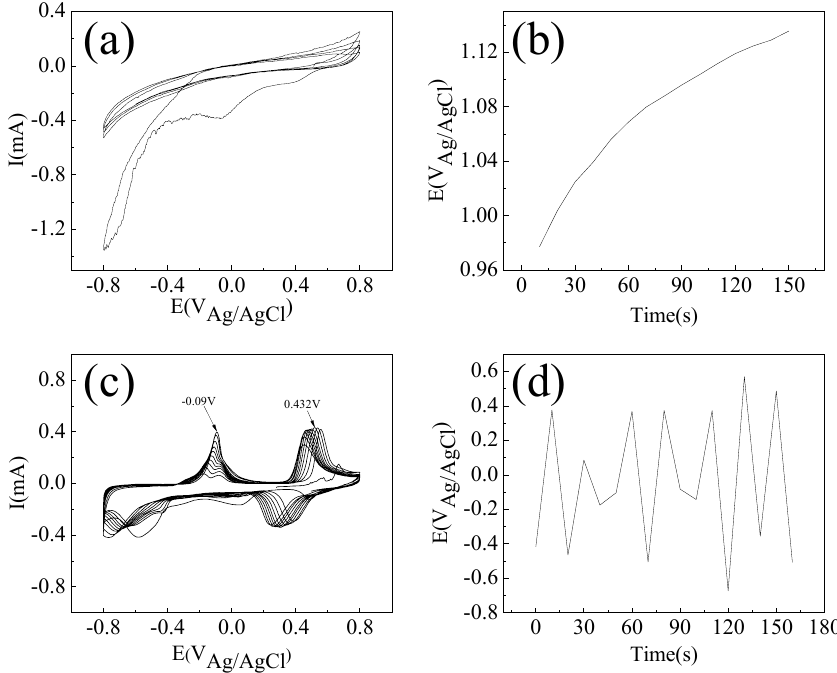
Figure 3. Cyclic-voltammetry (CV) characteristics of ( a ) MOF-235 and ( c ) TiO 2 -P25 mesoporous composite. The charge discharge performance of ( b ) MOF-235 and ( d ) TiO 2 -P25 mesoporous composite. All experiments were tested in 1M NaCl electrolyte at room temperature. The electrolysis cell was composed of a standard three-electrode arrangement using a Pt sheet counter electrode and a saturated Ag/AgCl reference electrode.